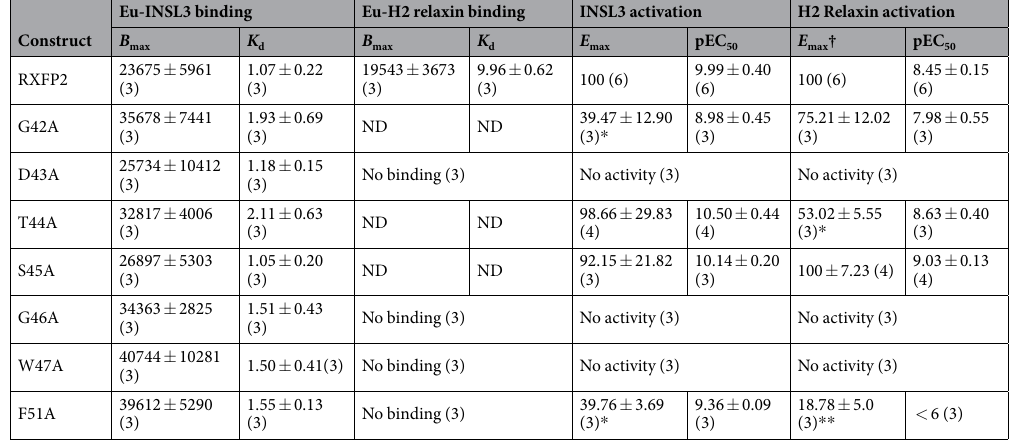
Table 1. Activity data for RXFP2 mutants compared to wild-type RXFP2. * Indicates p < 0.05, ** indicates p ≤ 0.01, *** indicates p ≤ 0.001. E max : maximal cAMP response, % maximal RXFP2 activity; pEC 50 : H2/INSL3 potency of RXFP2 receptor; K d : dissociation constant for relaxin or INSL3 binding; B max : maximal binding; ND: not done. Number of individual assays performed in parentheses; † Max value based on 1 µ M